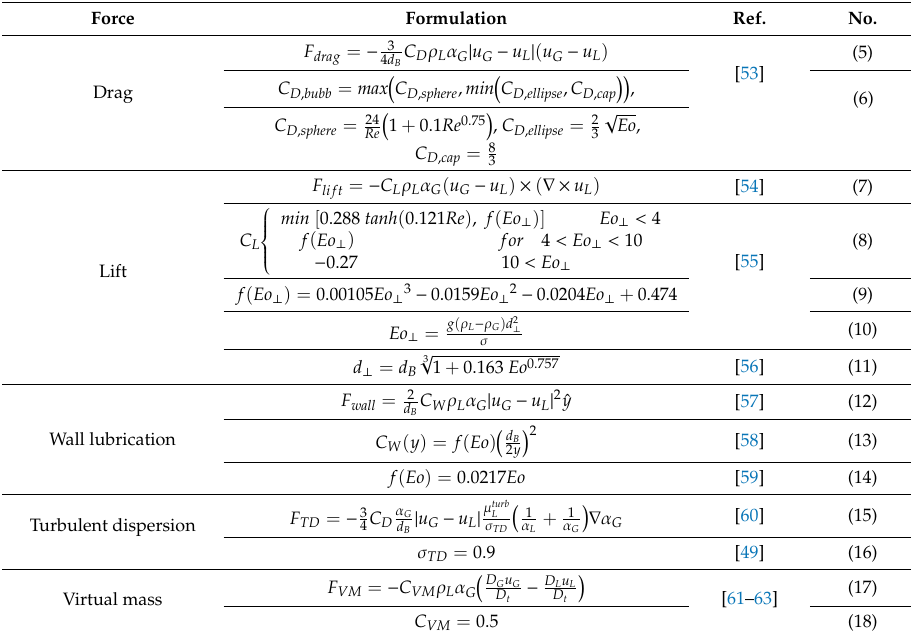
Table 1. Closure models for the polydispersed gas phase based on the baseline model concept [50]. The table is taken from